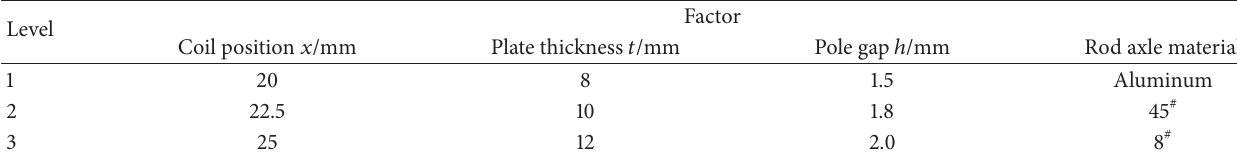
Table 5: The factors and levels.